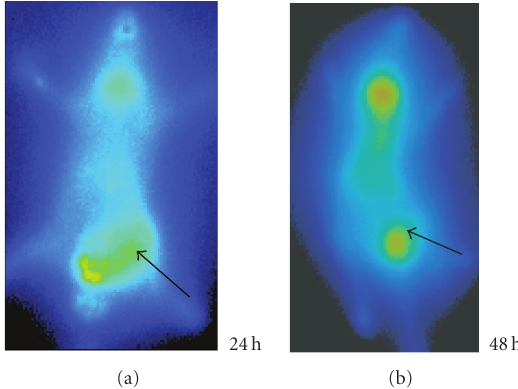
Figure 6: Serial images of E. coli group at di ff erent times: after 48 hours image of the left thigh inflammation foci was clear, but the amount of radioactivity was less than S. aureus or turpentine